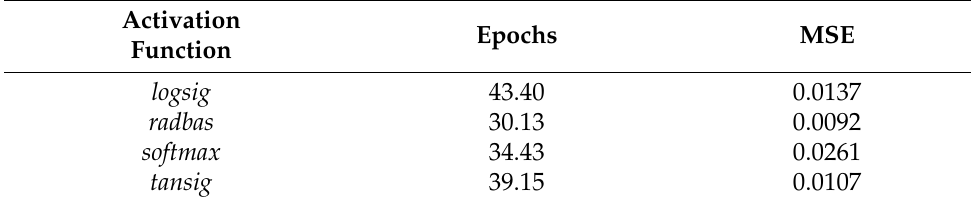
Table 5. Parameters of the network.